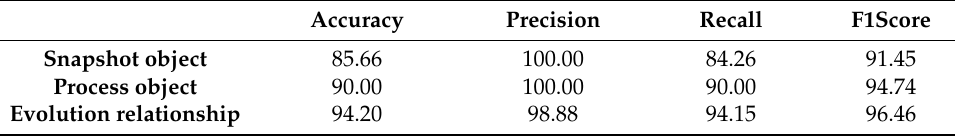
Table 3. Evaluations of snapshot objects, process objects, and evolution